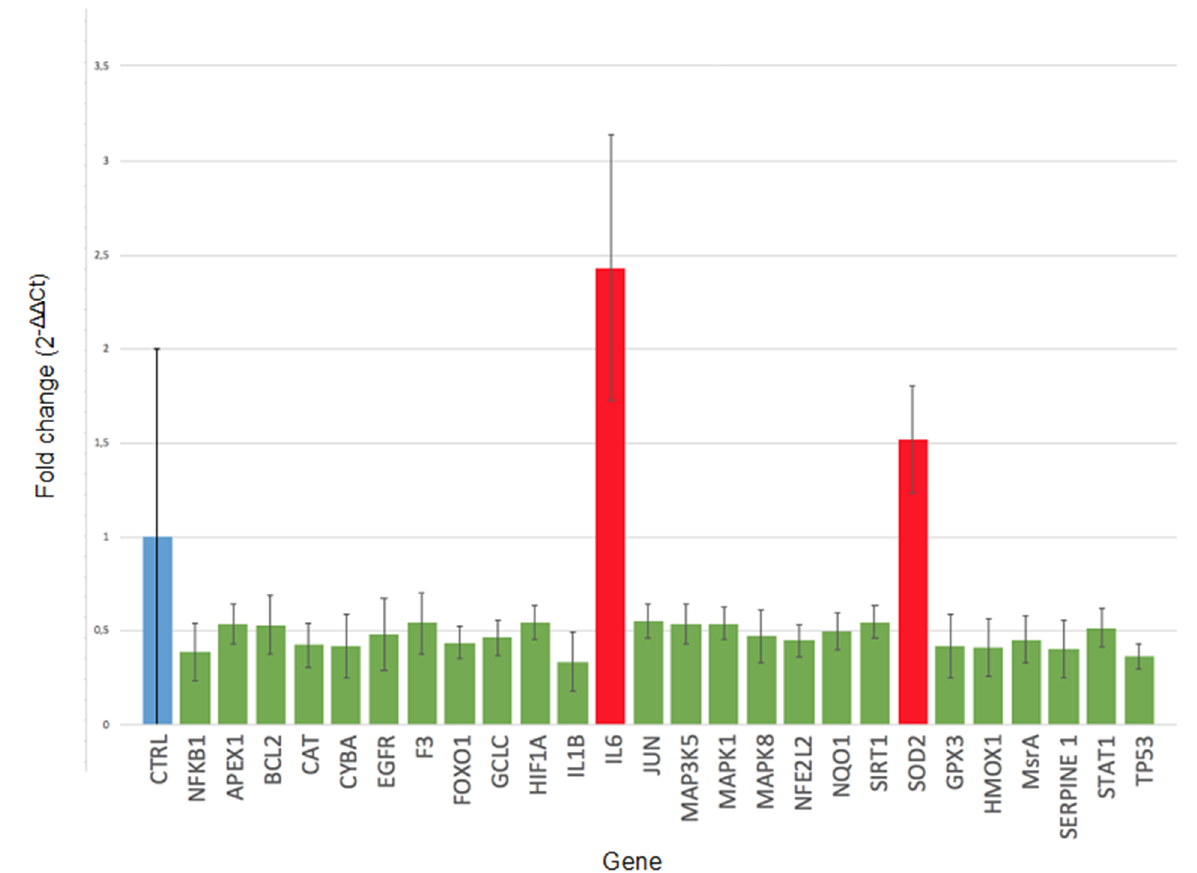
Figure 1. Significant mean fold change values for all differentially modulated genes in cumulus cells of female smokers undergoing IVF treatments ( p < 0.05).